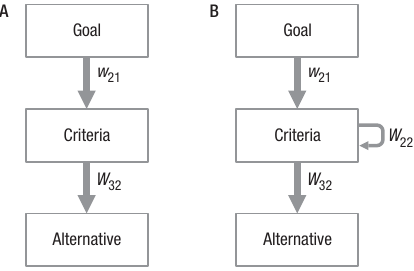
Fig. 2. Hierarchy and network: (A) hierarchy; (B)